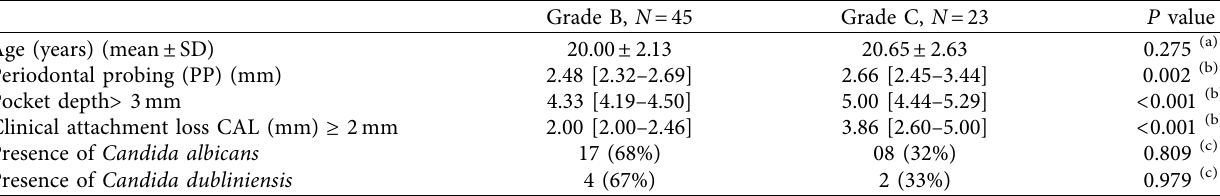
Table 4: Comparison of age, clinical variables, and presence of Candida albicans and Candida dubliniensis according to grades in periodontitis